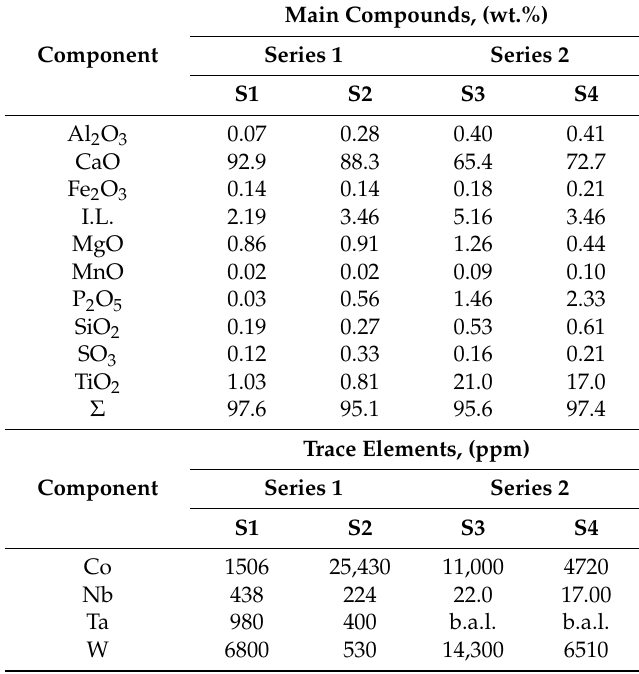
Table 4. Main compounds and trace elements of the annealed precipitates at the end of each test series processing the initial solutions S1, S2, S3, and S4, analysed by X-ray fluorescence (XRF) (I.L., ignition loss) [3]. Main Compounds,